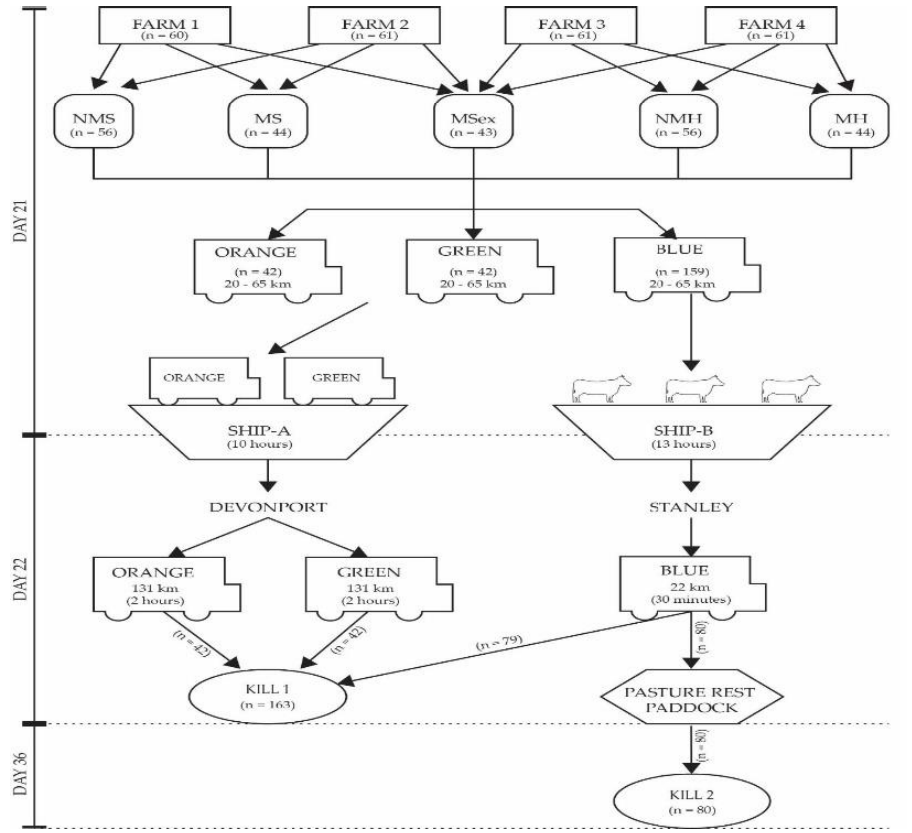
Figure 1. Experiment One diagram of timeline methodology for mixing, transport and slaughter interval. NMS, never mixed steers; NMH, never mixed heifers; MS, mixed steers; MH, mixed heifers; MSex, mixed steers and heifers. The truck symbol denotes trucking pathway and cattle symbol denotes cattle were unloaded and on foot rather than in trucks. The arrows represent the direction of cattle movement and dotted lines represent timeline. Any parameter that intersects the dotted line occurred over multiple days.